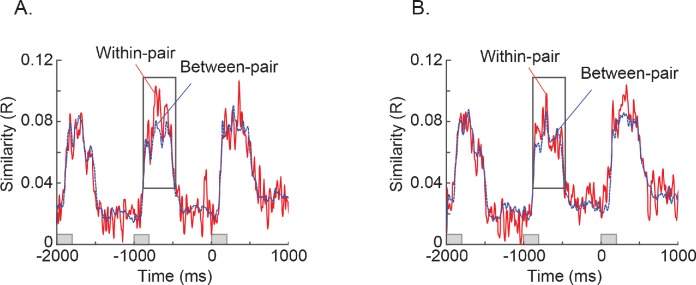
Results of the Spatial Representational Similarity Analysis for two subsets of trials where (A) sentences ending with expected words were seen first or (B) sentences ending with unexpected words were seen first.The time series of spatial similarity R values for the pairs in which the same word was predicted (within-pair) are shown in red, while the time series for the pairs in which a different word was predicted (between-pair) are shown in blue. The spatial similarity was greater when the same word was predicted than when different words were predicted in both subsets. No significant difference was found between the two subsets of trials, as indicated by the lack of a main effect of Order (Expected First, Unexpected First) (F(1,25) = 0.747, p = 0.396, η2 = 0.029) or an interaction between Order (Expected First, Unexpected First) and Pairs (Within-pair, Between-pair) (F(1,25) = 1.804, p = 0.191, η2 = 0.067).